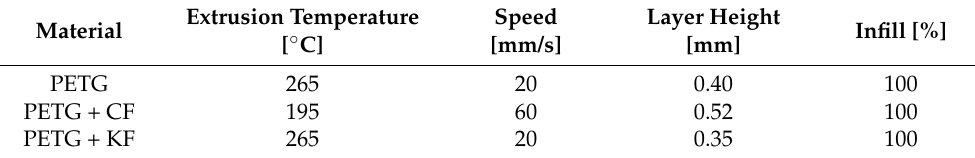
Table 1. Printing parameters for each material.